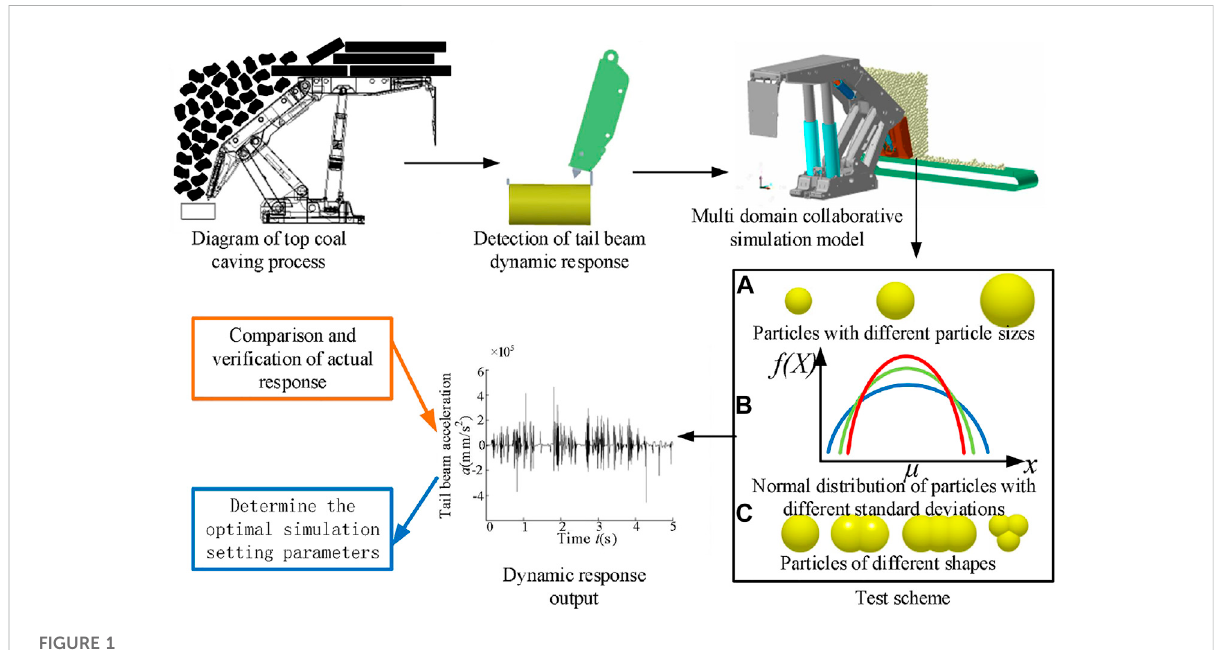
FIGURE 1 Research process mind